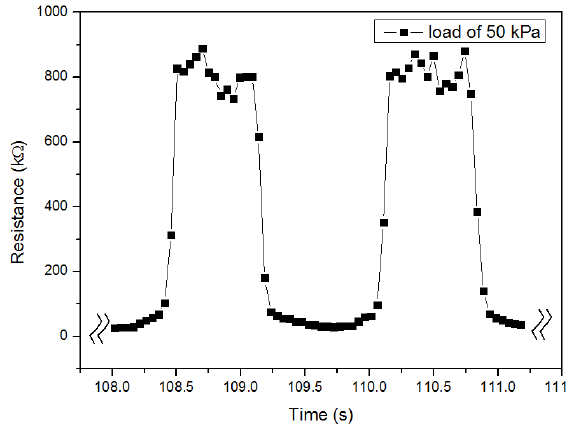
Figure 9. Response and recovery time of the pressure sensor. Concentration of TS029 in PDMS: 50 wt %.